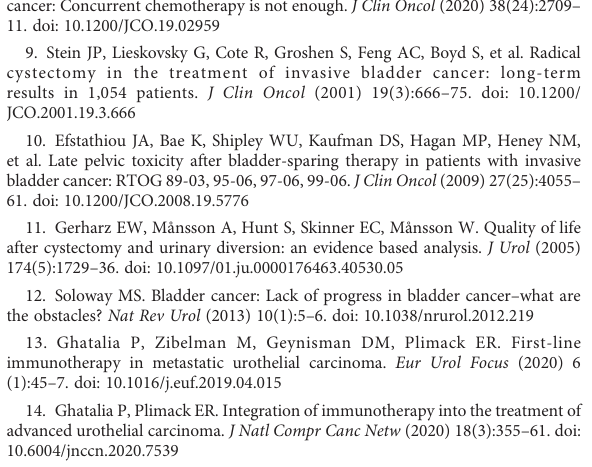
SUPPLEMENTARY FIGURE 1 Control of Mass Spectrometry Data Quality. (A) Following a general guideline based on acid hydrolysis and mass spectrometry fragmentation patterns, most fractions were classi fi ed into 7 – 20 amino acids. (B) The coverage of the majority of proteins is less than 30%. ( C ) The detected proteins ’ molecular weights were present at various stages and uniformly dispersed. (D) The majority of proteins correspond to several peptides. SUPPLEMENTARY FIGURE 2 In Pearson ’ s correlation plot, the correlation values (r) between samples are